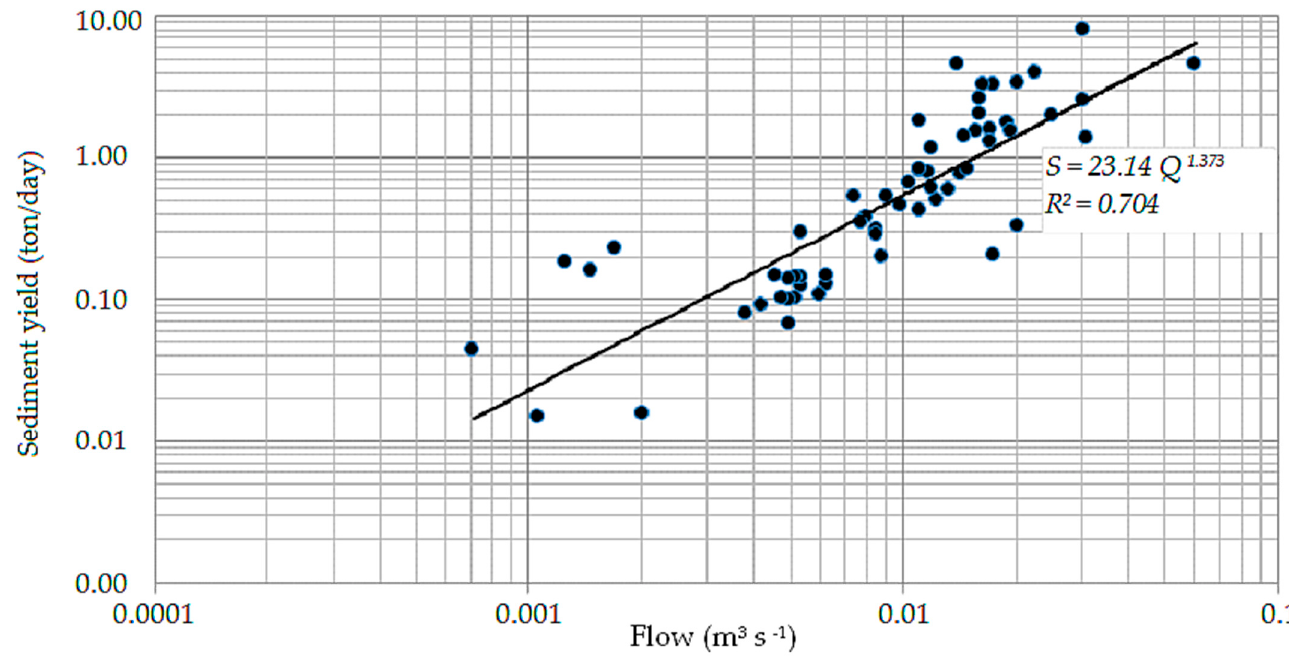
Figure 2. Sediment rating curve of Koga River at Koga-Merawi gauge station.